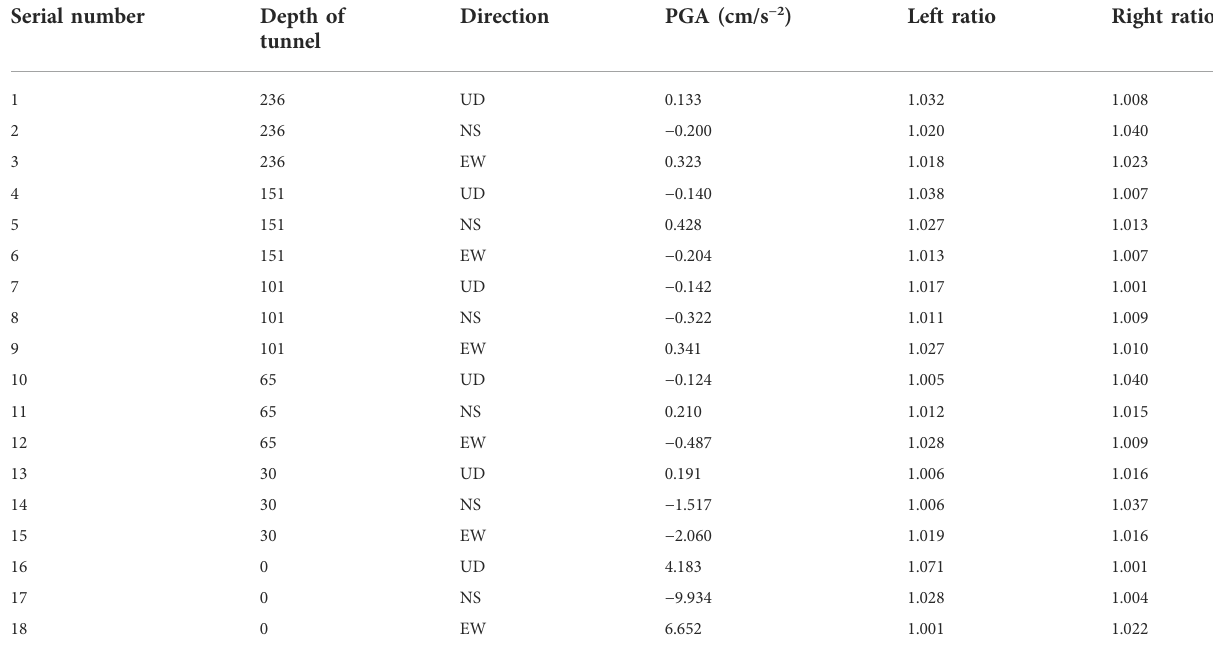
TABLE 2 Ratios of the strong Guye earthquake